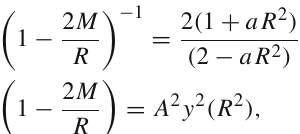
Fig. 2 Radial pressure